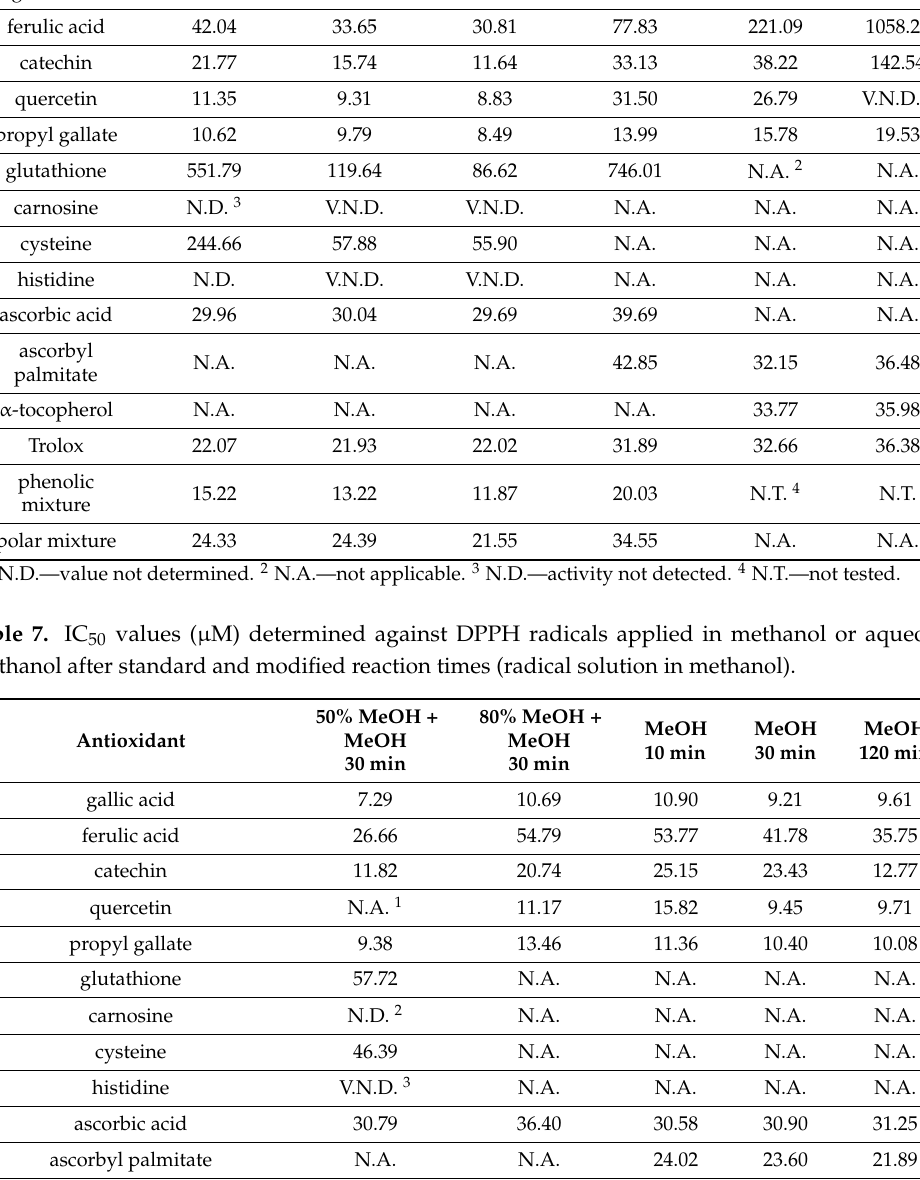
radicals, emphasized by Decker et al. [18], corresponds to the data obtained in this paper in